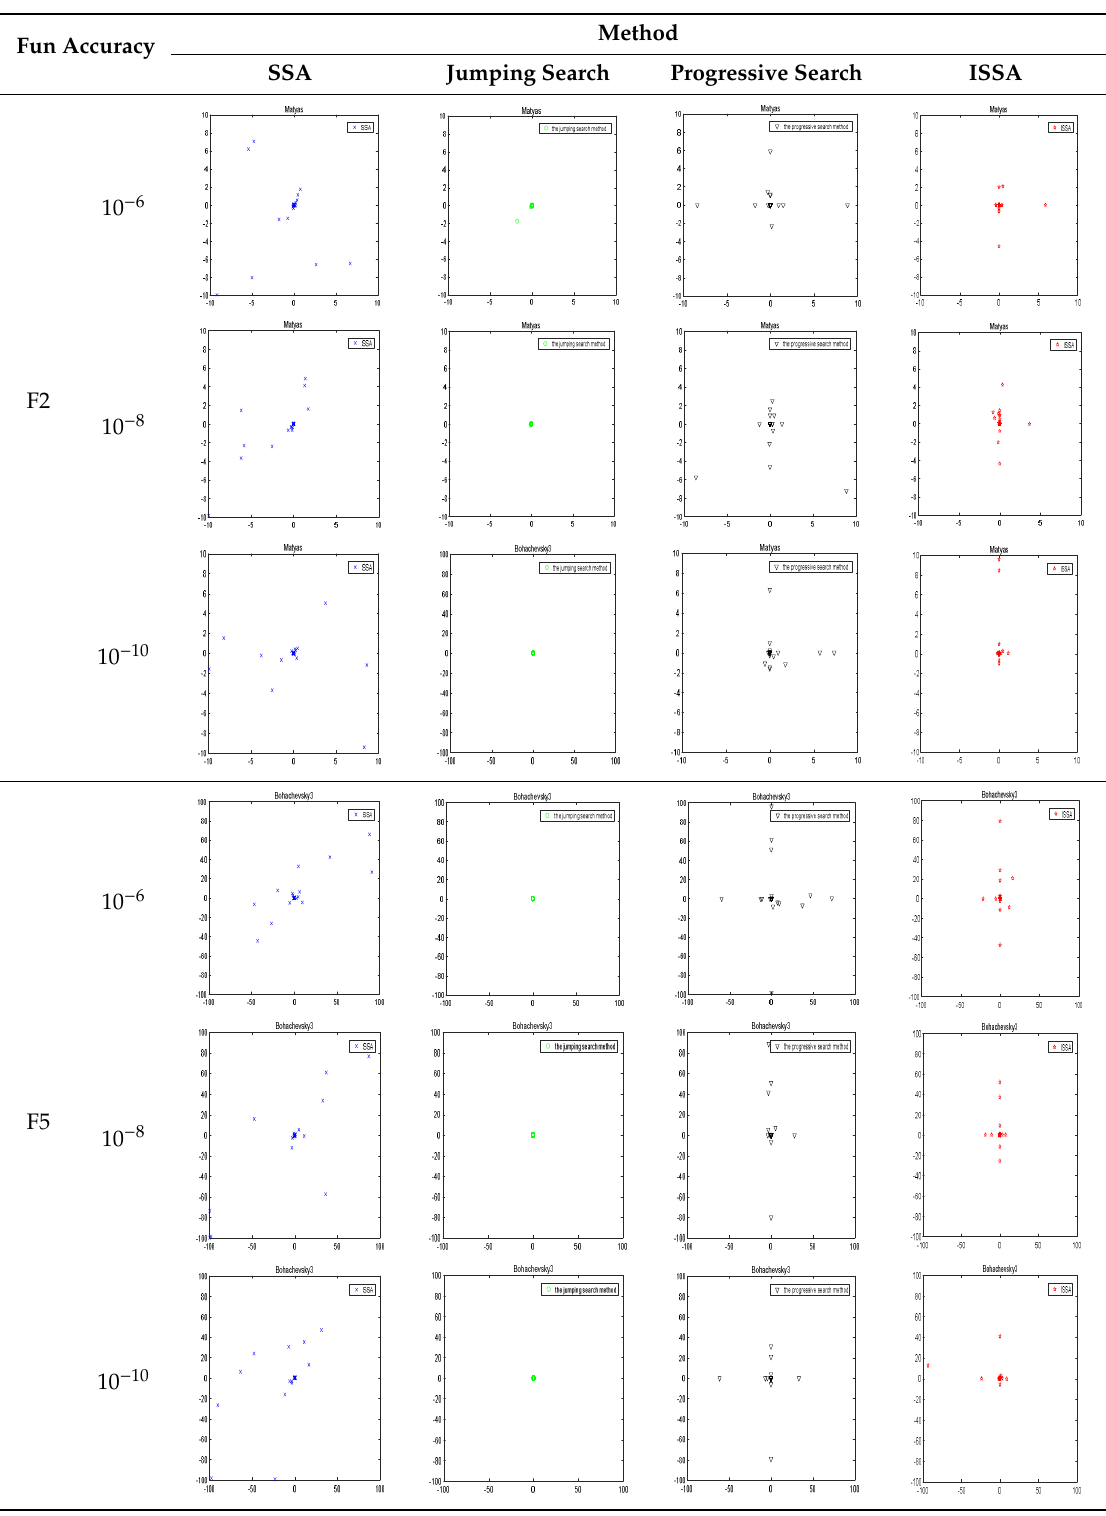
Table 3. The comparison of the individuals’ distribution.